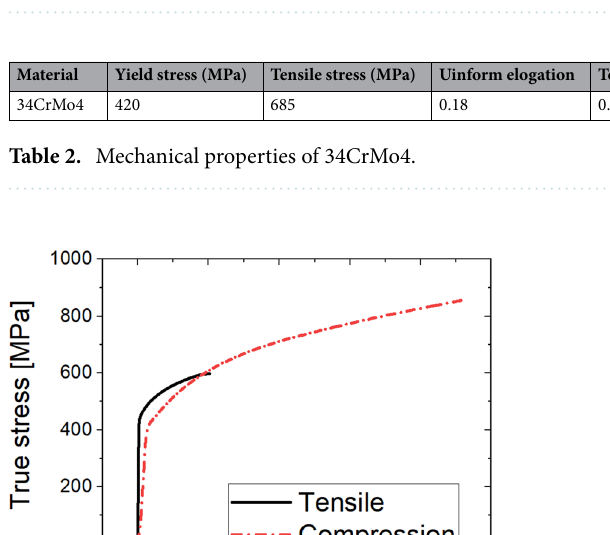
Figure 2. Tensile and compression test specimens with detailed dimension.